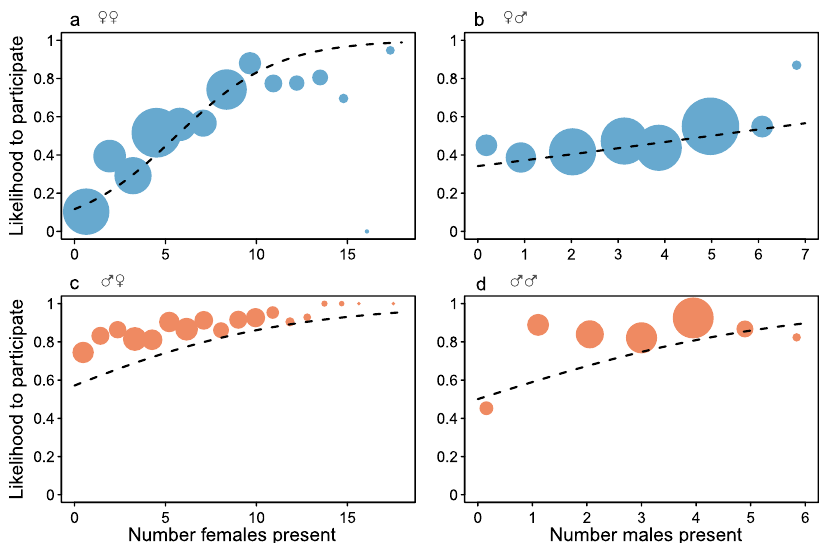
Fig. 1 Does ‘ strength in numbers ’ in fl uence participation? The effects of the presence of number of other females ( a and c ) and males ( b and d ) on the likelihood to participate in intergroup encounters in females (blue, 75 individuals) and males (orange, 36 individuals). Larger point denotes larger number of observations and dashed lines represent the model lines. Source data are provided as a Source Data fi le.